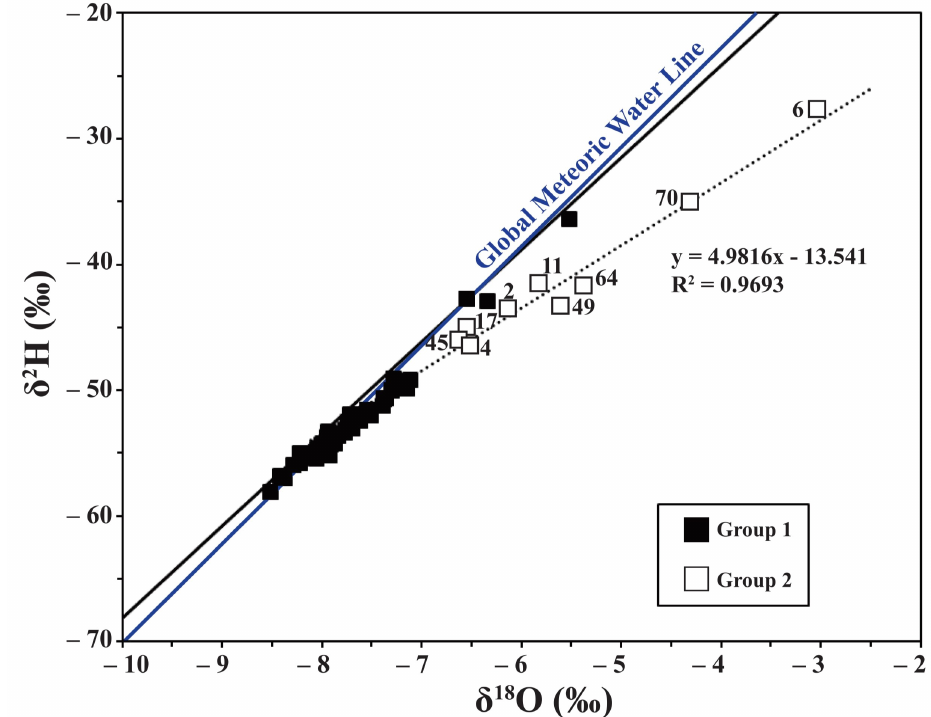
Figure 9. Isotopes of δ 2 H and δ 18 O of groundwater compared with Bangkok Local Meteoric Water Line (BKK